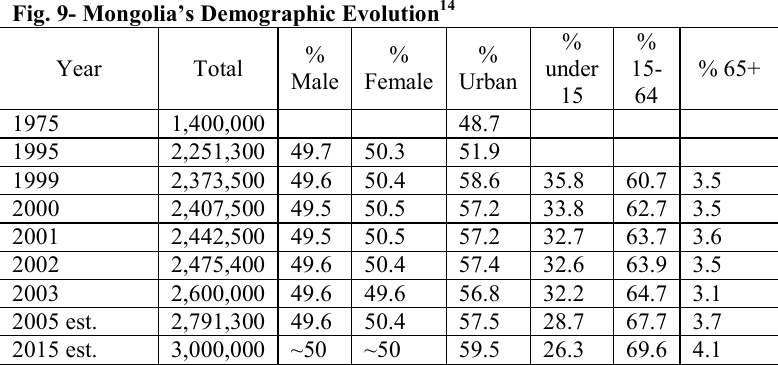
Fig. 9- Mongolia’s Demographic Evolution